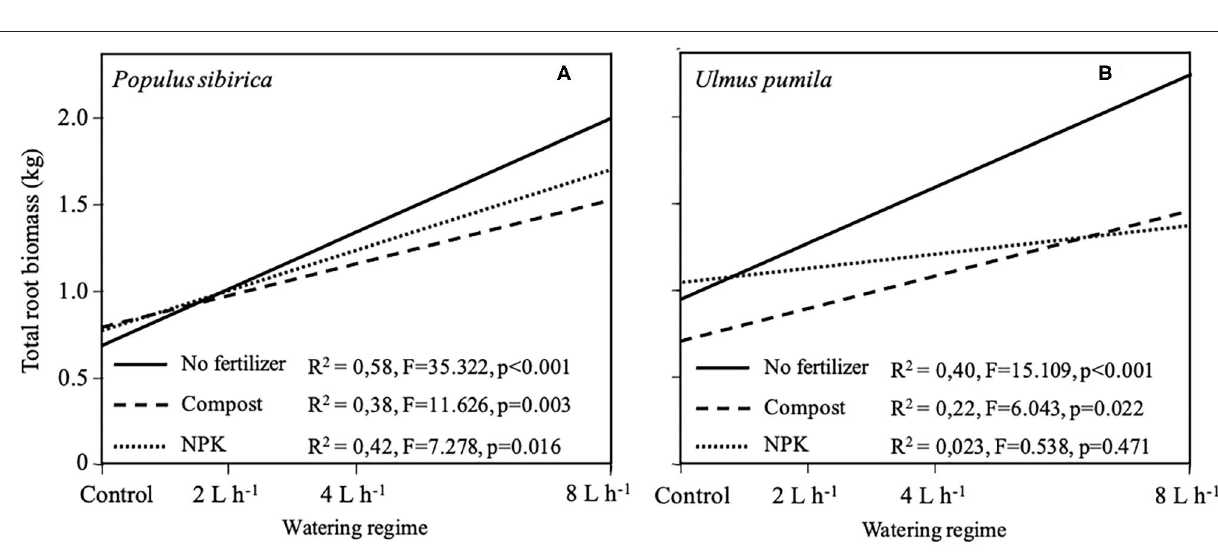
mechanisms (e.g., reduced leaf size and increased leaf thickness) to counteract arid environmental conditions (Park et al., 2016; Qin et al.,